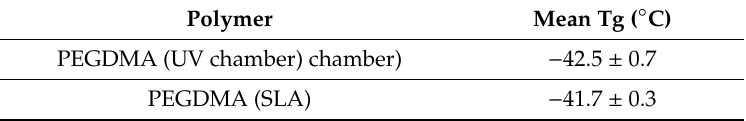
Table 2. Thermal properties of PEGDMA hydrogels prepared via UV chamber and SLA